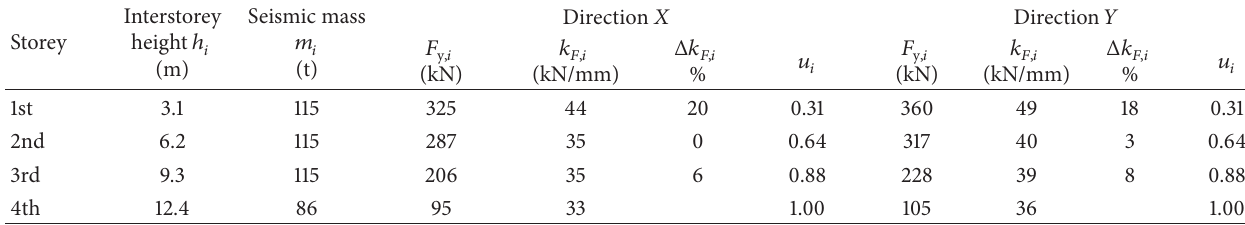
Table 2: Main characteristics of each storey of the bare structure.